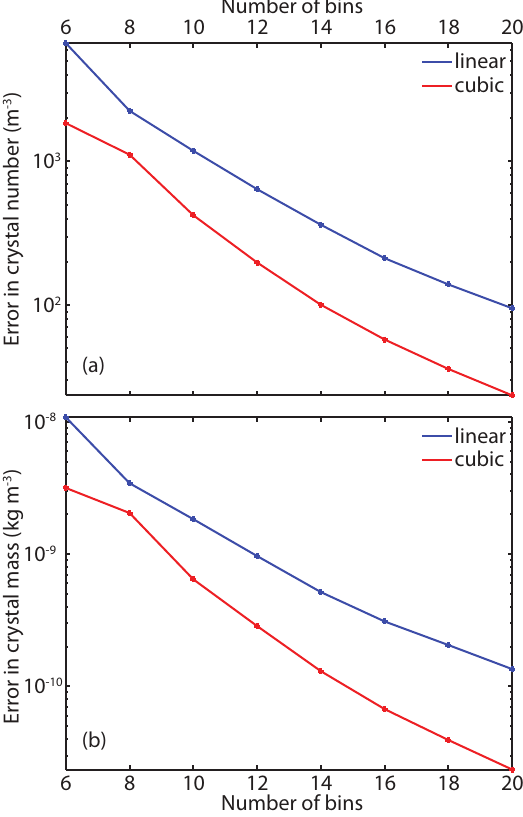
Fig. 4. L 1 errors in (a) number and (b) mass of ice crystals of the solutions at 50 min obtained by the linear and cubic schemes in the depositional growth problem. The errors are plotted in logarithmic